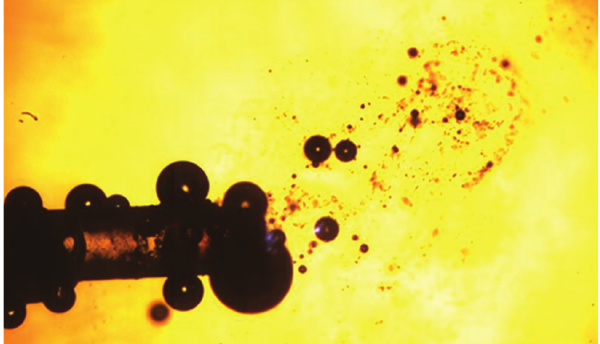
Fig. 5. Directed two-phase jet °ows formed near the ¯ber tip during irradiation by laser with a SAC tip at 6W. Recording rate is 2000 frames per